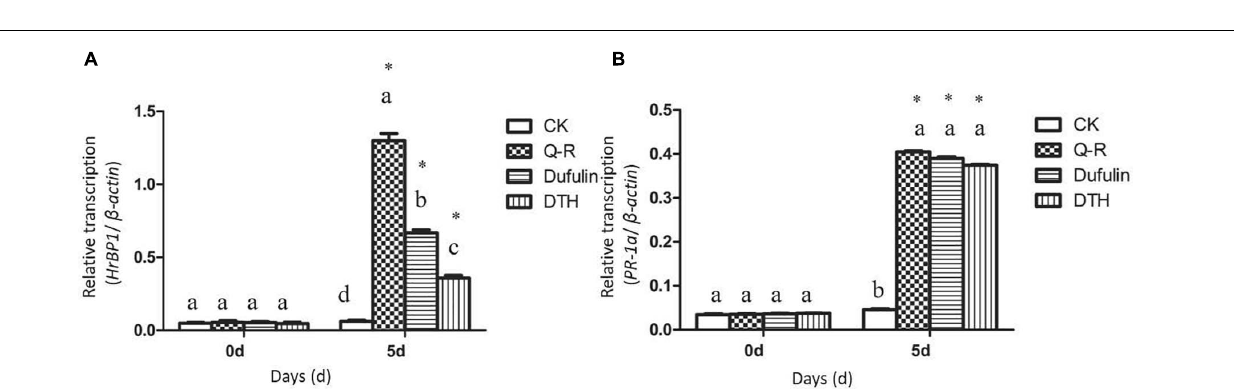
FIGURE 1 | The chemical structures of antiviral agents.